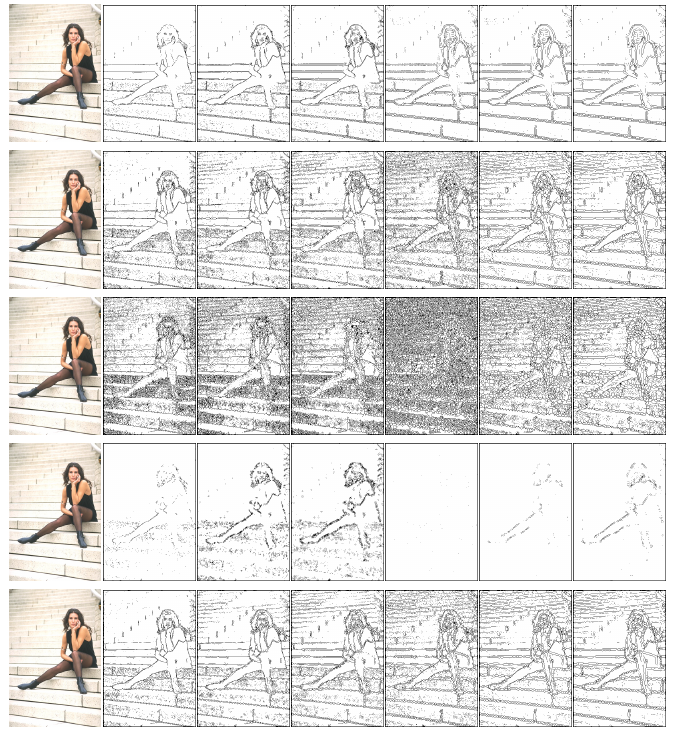
Figure A10. Laplace operators and Laplace of Gaussian results. Columns: Original, Laplace 3 × 3, Laplace Dilated 5 × 5, Laplace Dilated 7 × 7, LoG 3 × 3, LoG 5 × 5, LoG Dilated 5 × 5 and LoG Dilated 7 × 7 Rows: Laplace kernel V1, Laplace kernel V2, Laplace kernel V3, Laplace kernel V4 and Laplace kernel V5.